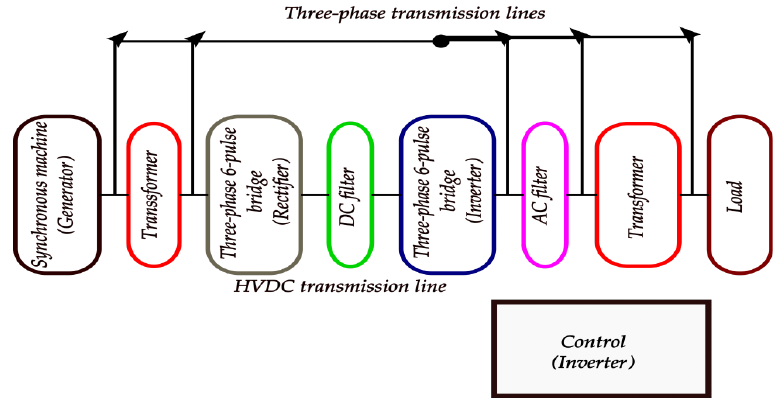
Figure 4. Model of HVDC Monopolar